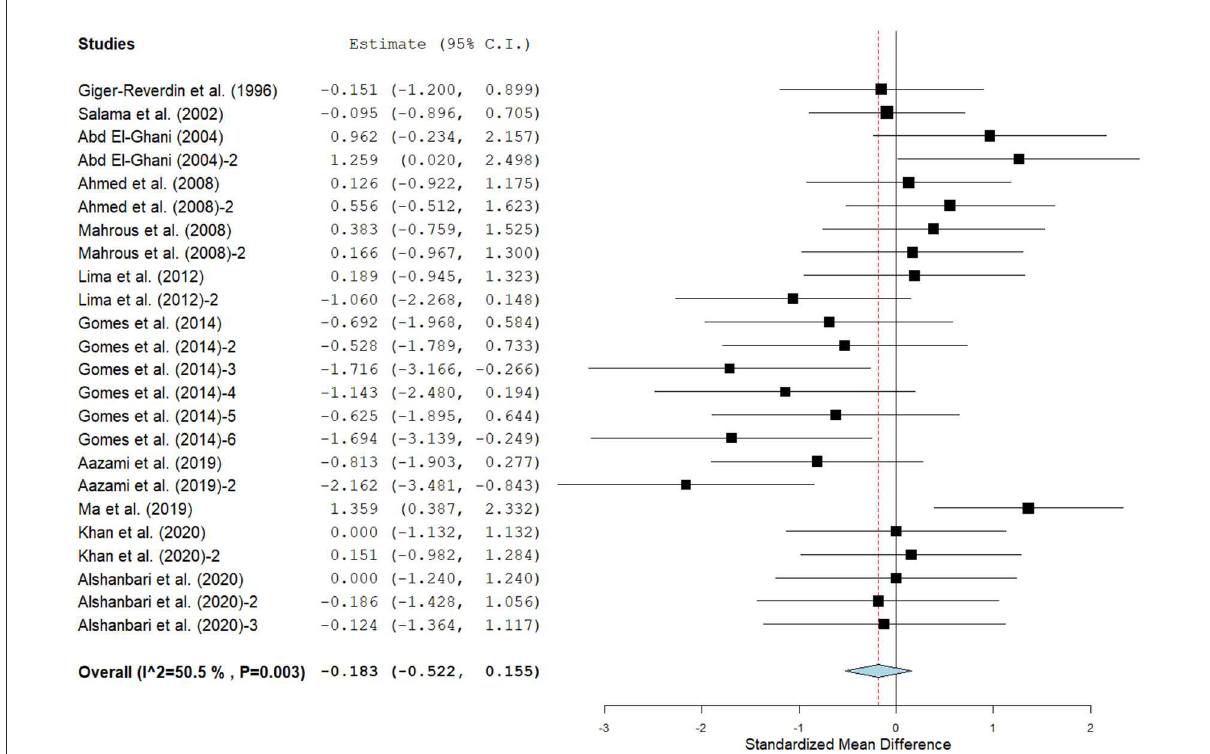
FIGURE2 Forest plot of SMD for DMI in lactating goats. The error bars (black square boxes) connote the SMD of each trial, while the upper and lower 95% confidence intervals (CIs) for the effect size are the line that joined the individual square box. The thick vertical line is the line of no effect (SMD = 0), which suggests no effect of SC supplementation on milk yield. The sky-blue diamond at the base of the plot indicates the pooled SMD with its width representing the 95% confidence intervals for the effect size. The points to the right of the line of no effect suggest an increase in DMI. The points to the left of the line of no effect connote an increase in DMI. I 2 is the inconsistency